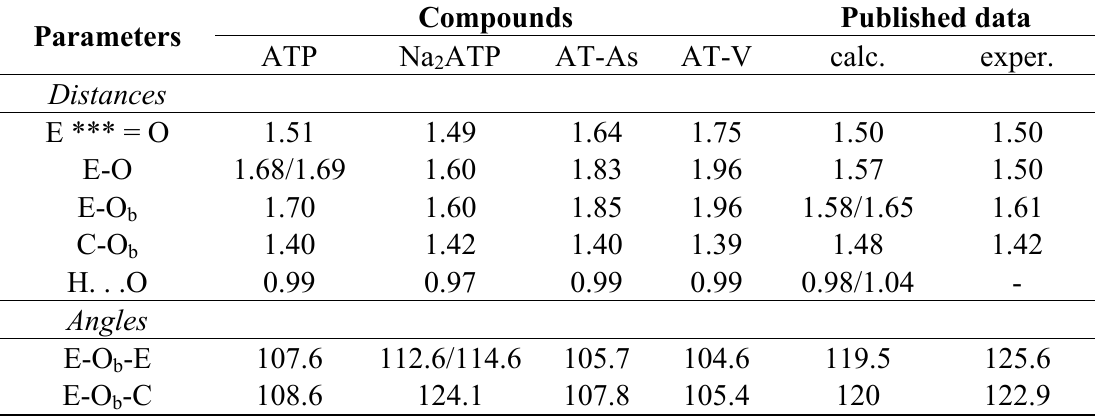
Table 2. Structural parameters obtained for the adenosine triphosphate models, as compared with calculated [7] * and experimentally established [13] ** values.